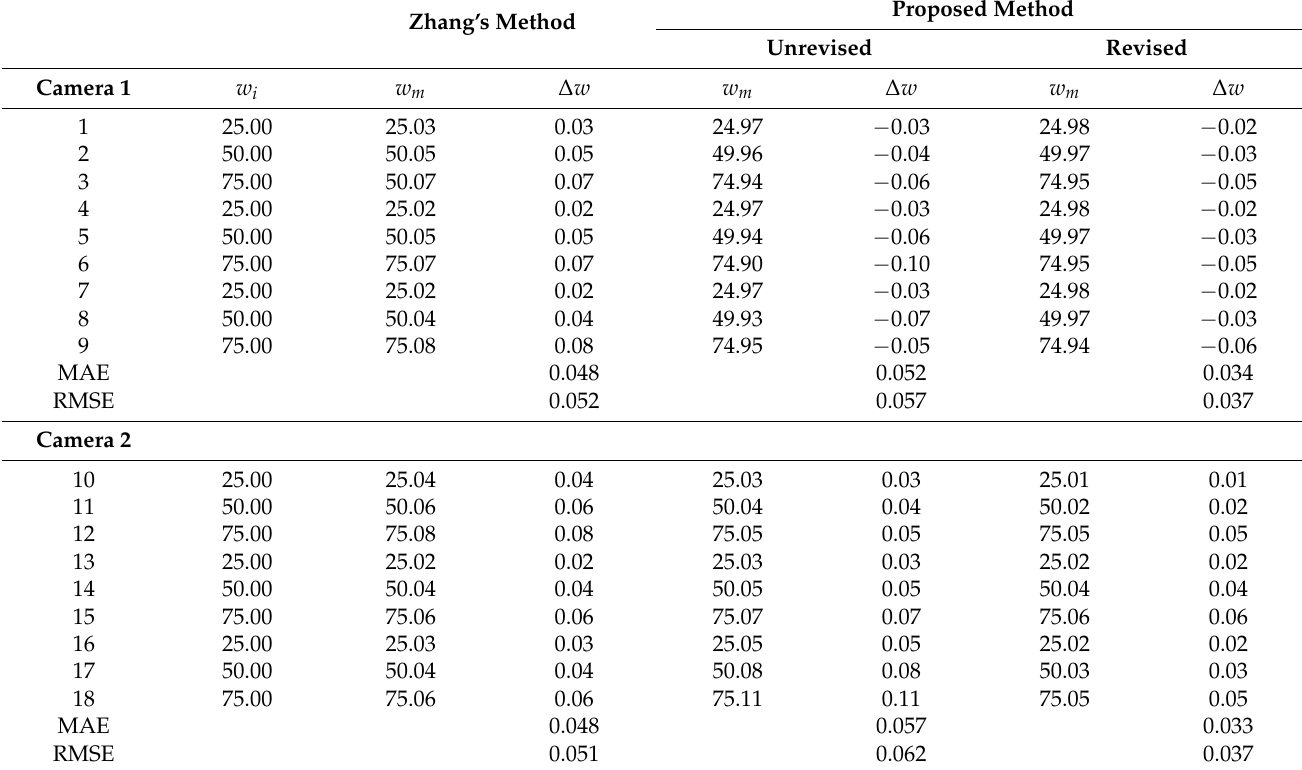
Table 3. Analysis of calibration accuracy